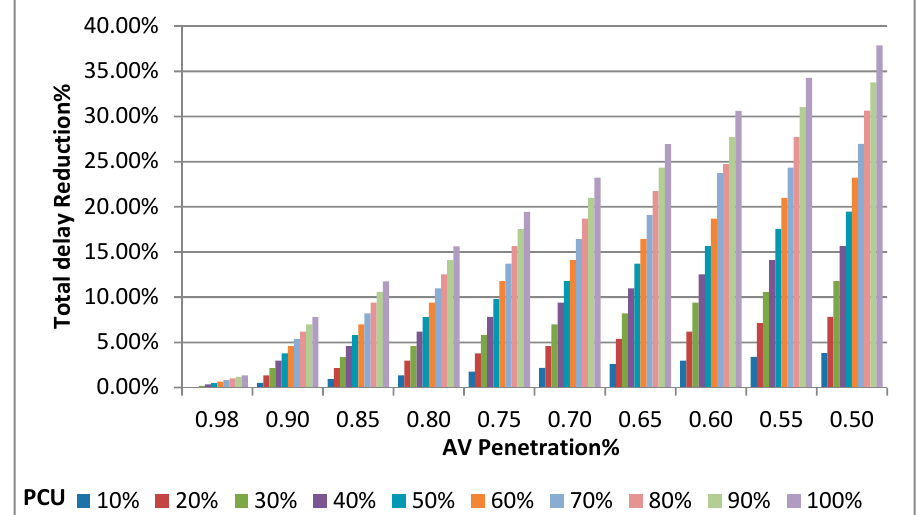
Figure 6. Reduction percent in total delay for different AV penetration and PCU.